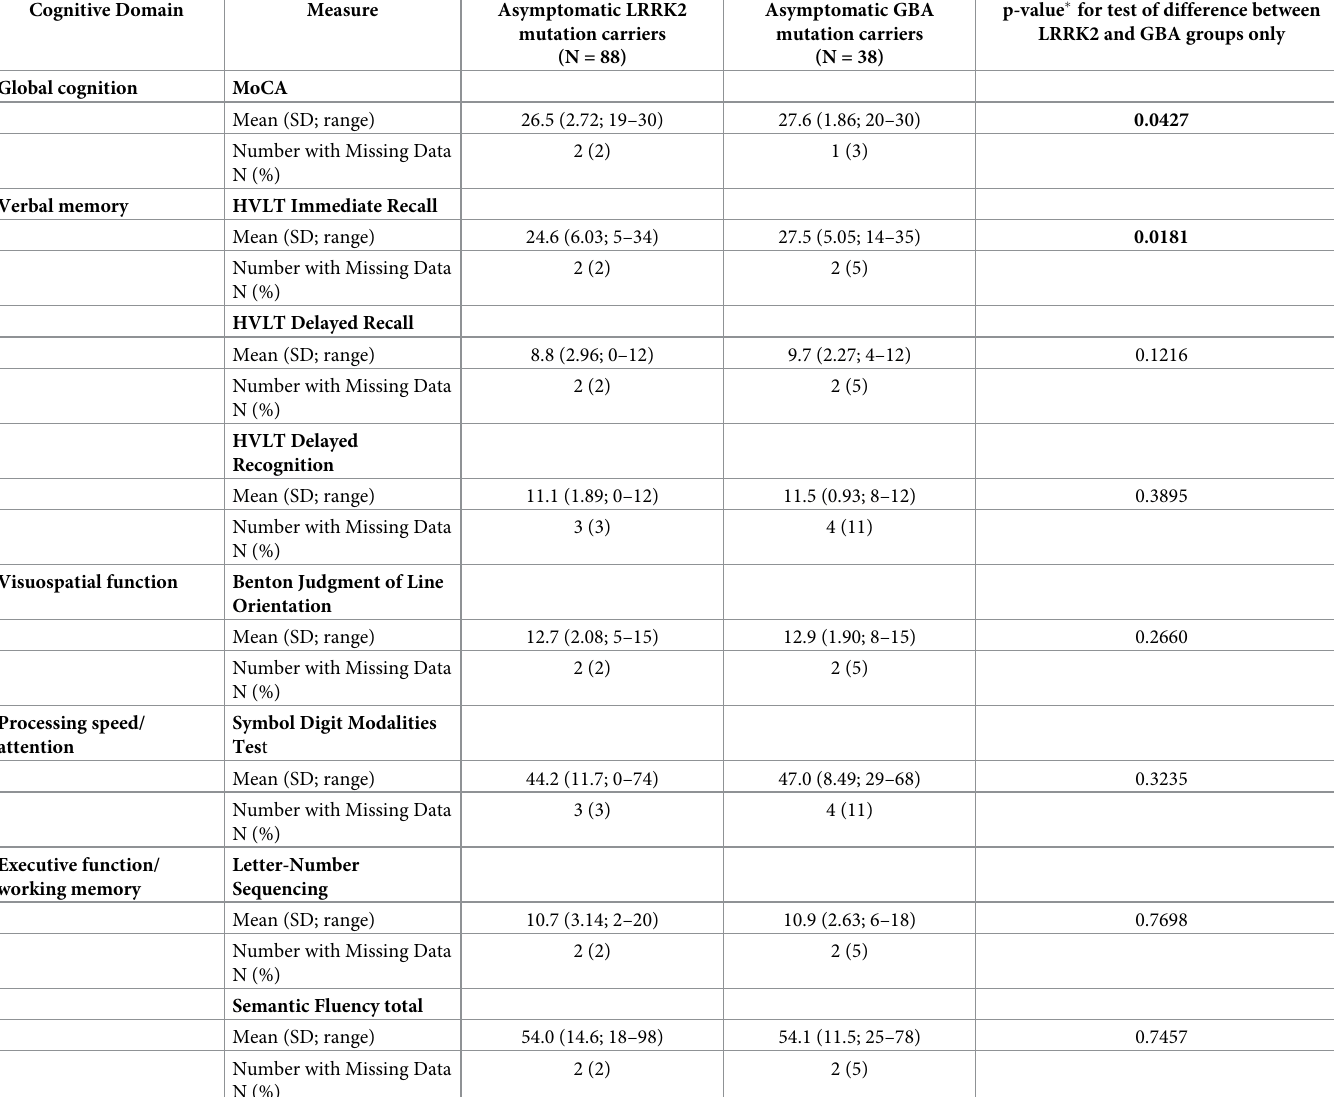
Table 3. Cognitive performance in the LRRK2 G2019S and GBA mutation carrier